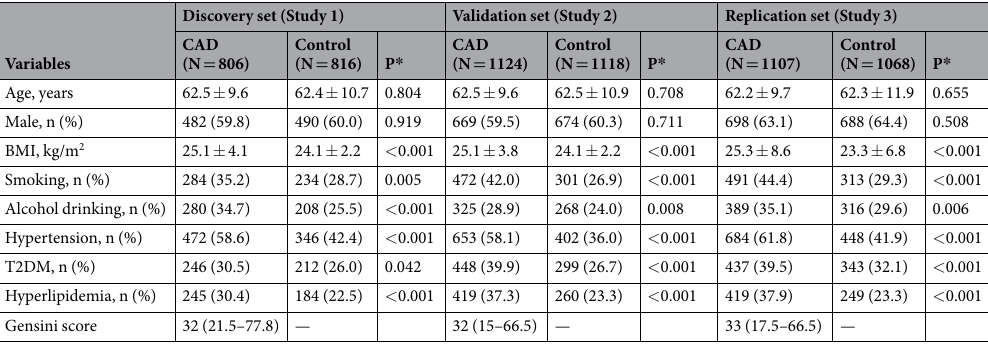
Table 1. Baseline and clinical characteristics of study populations. * For continuous variables, normally distributed data are expressed as mean ± standard deviation (SD), while skewed data are described as median (interquartile range). For categorical, data are expressed as frequency